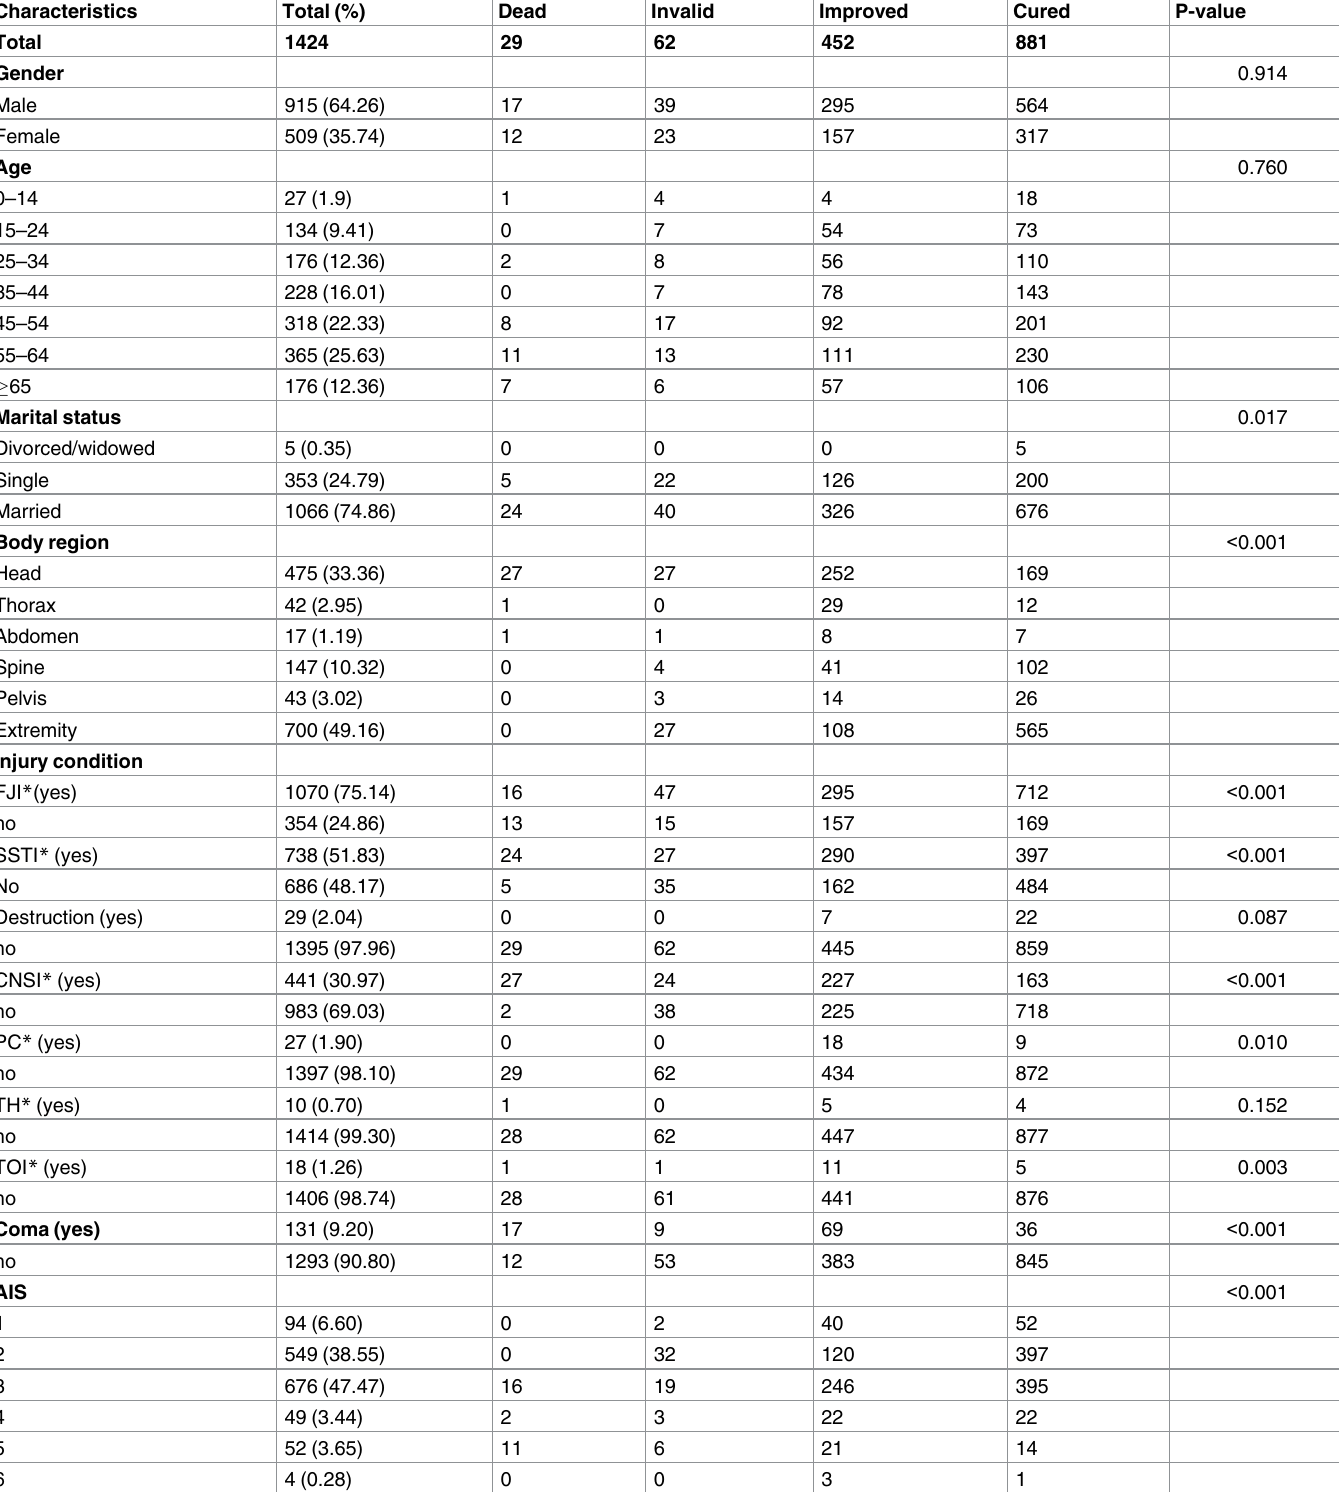
Table 1. Descriptiveanalysis and univariate analysis of single-RTI